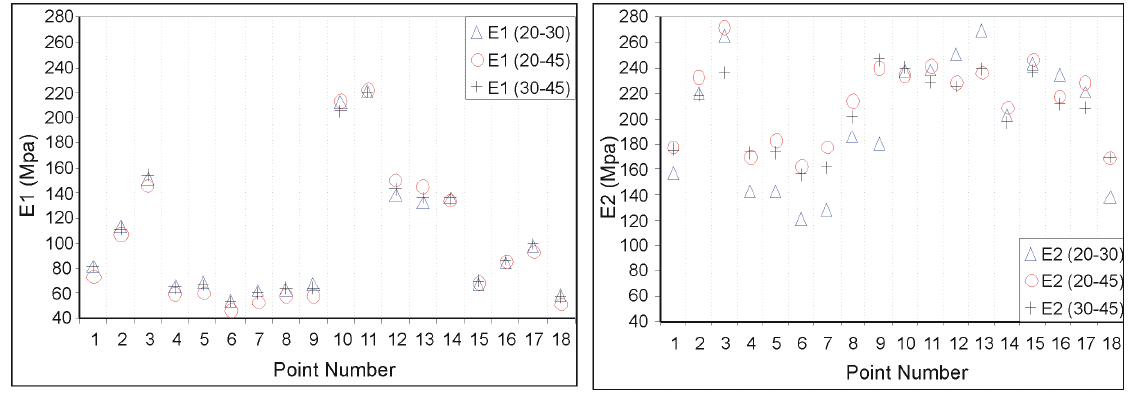
Fig. 5. The effect of distances of extra geophones on layers